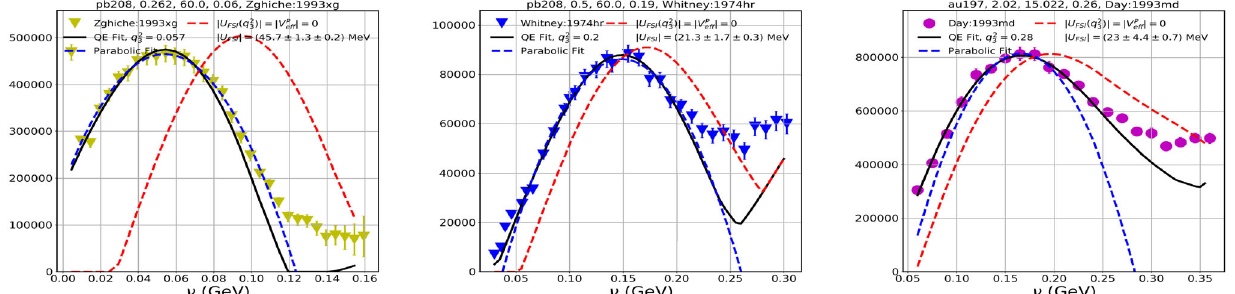
= 0 . 254 GeV) QE differential cross sections Fe ( k P F 20